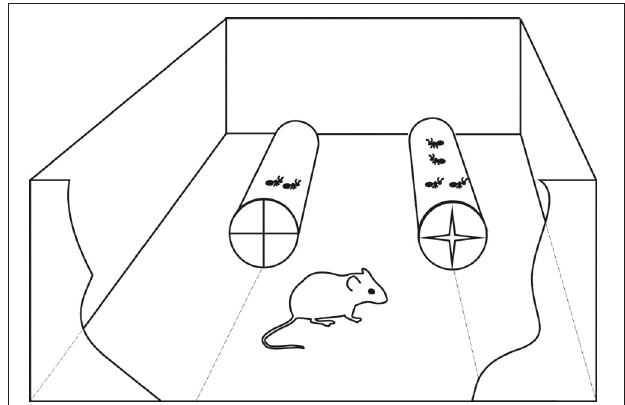
FIGURE 3 | Experimental setting used: tunnels contain different number of live ants. It is shown in the right tunnel how crosswise slits allow a mouse to pass in and out by applying its own weight. Note that in reality mice had to choose between 5 and 15 ants (and so on, see the text), and never between 2 and